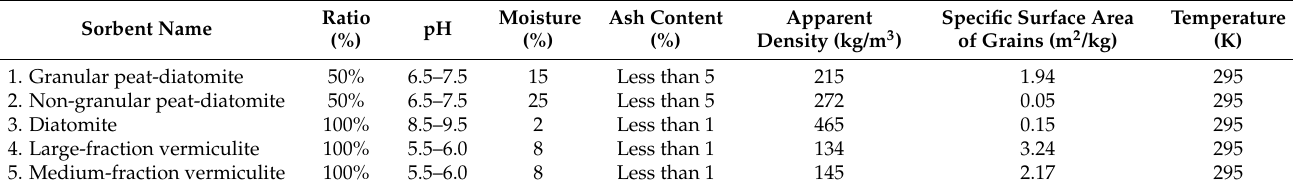
Table 1. Characteristics of the natural sorbents discussed in the